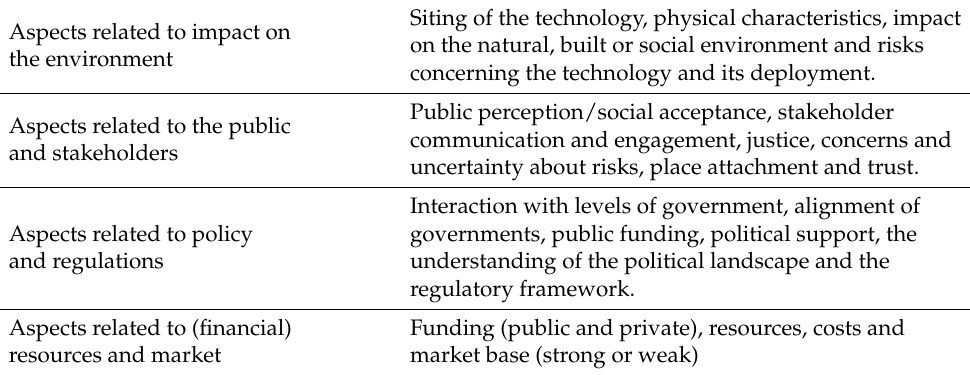
Table 1. Societal aspects divided in four